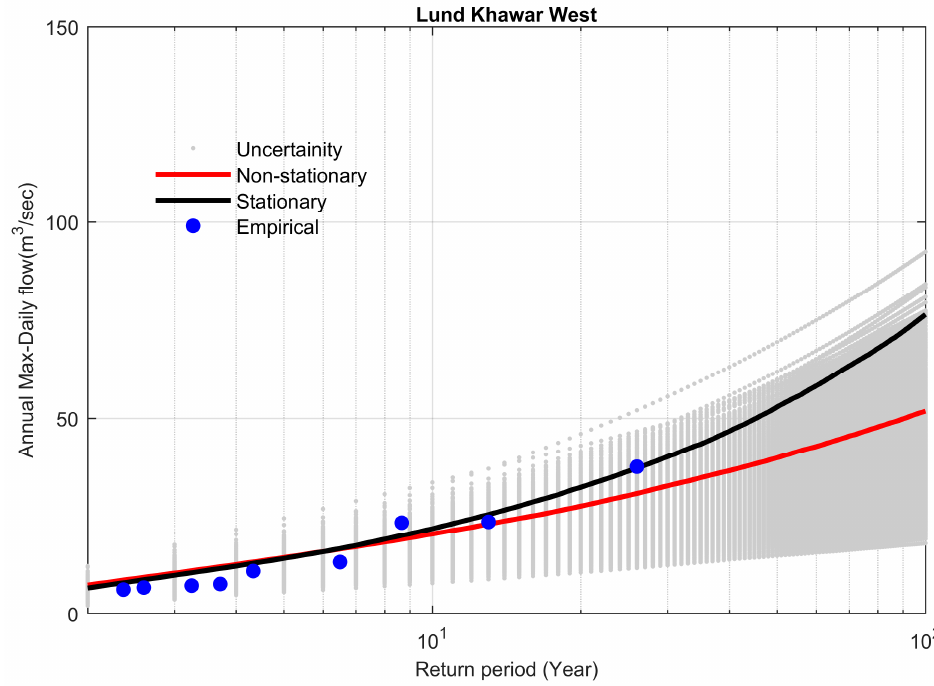
Figure 7. Comparison between non-stationary and stationary FFCs at site 22, along with non-stationary uncertainty bounds for the year 2016.